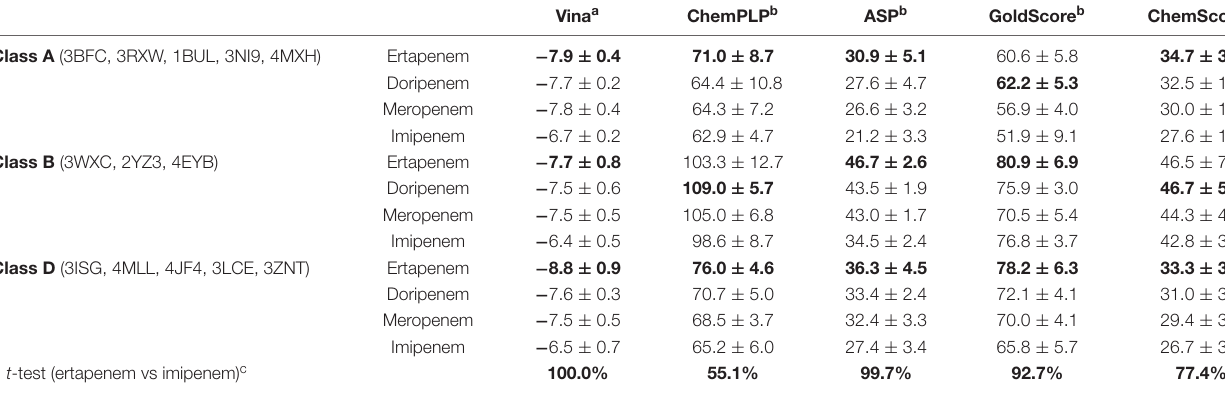
TABLE 2 | Results of the application of five independent scoring functions in the evaluation of the binding ability of the four carbapenems tested, against 13 X-ray structures of different carbapenemase enzymes from Classes A, B, and